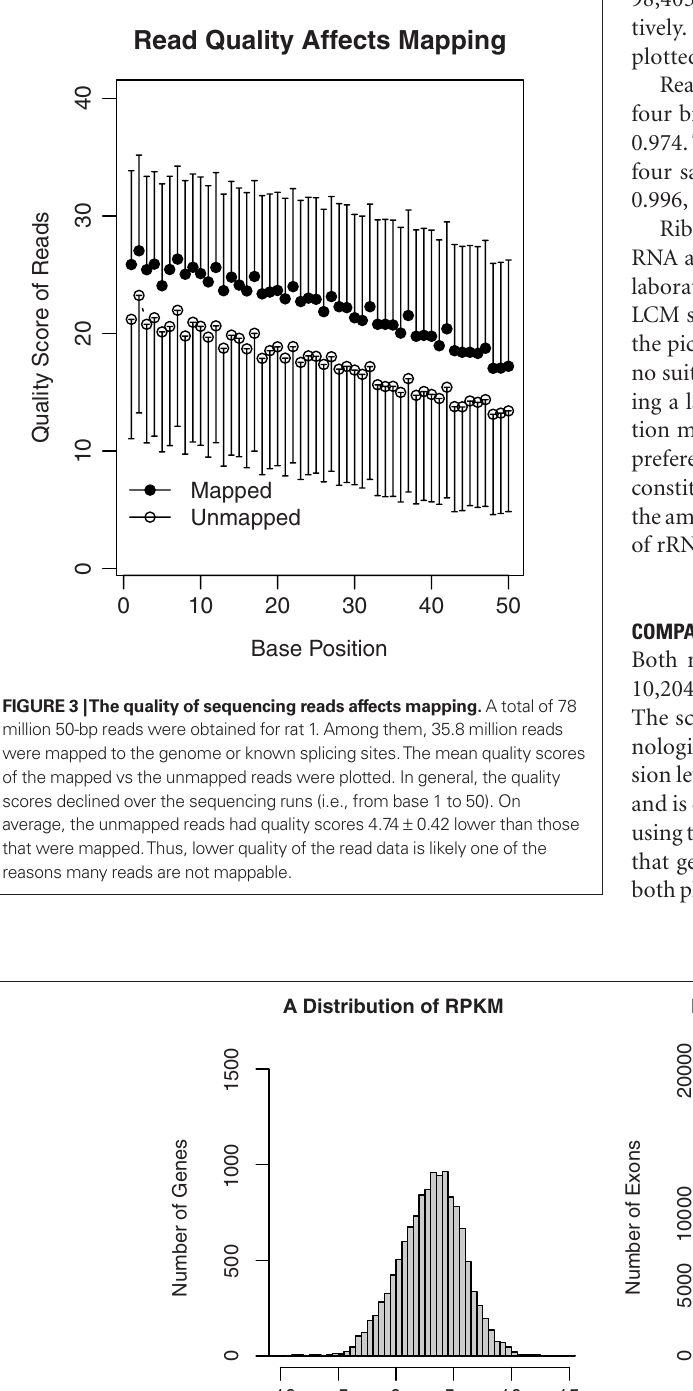
mapped to the rat reference genome and known splicing sites using the SHRiMP and TopHat programs, respectively. Gene expression levels (normalized to RPKM) were obtained using the Cufflinks program. A total of 11,000 unique RefSeq genes and 100,000 unique exons were detected. The distribution of mean RPKM for these genes (A) and exons (B) was